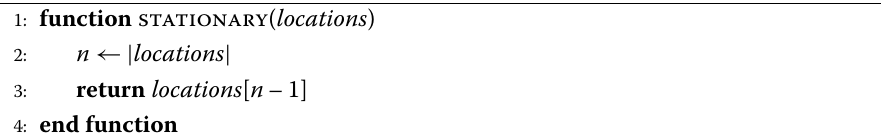
Algorithm 3 Stationary prediction